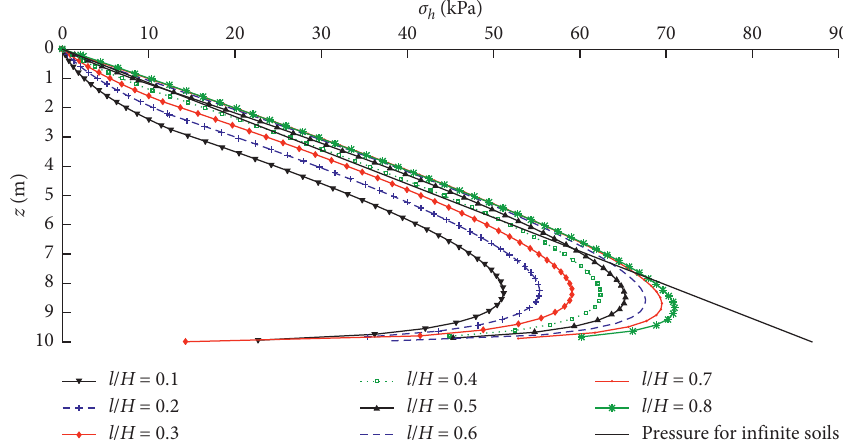
Figure 7: Distribution of active earth pressure under different l / H values ( H � 10 m).